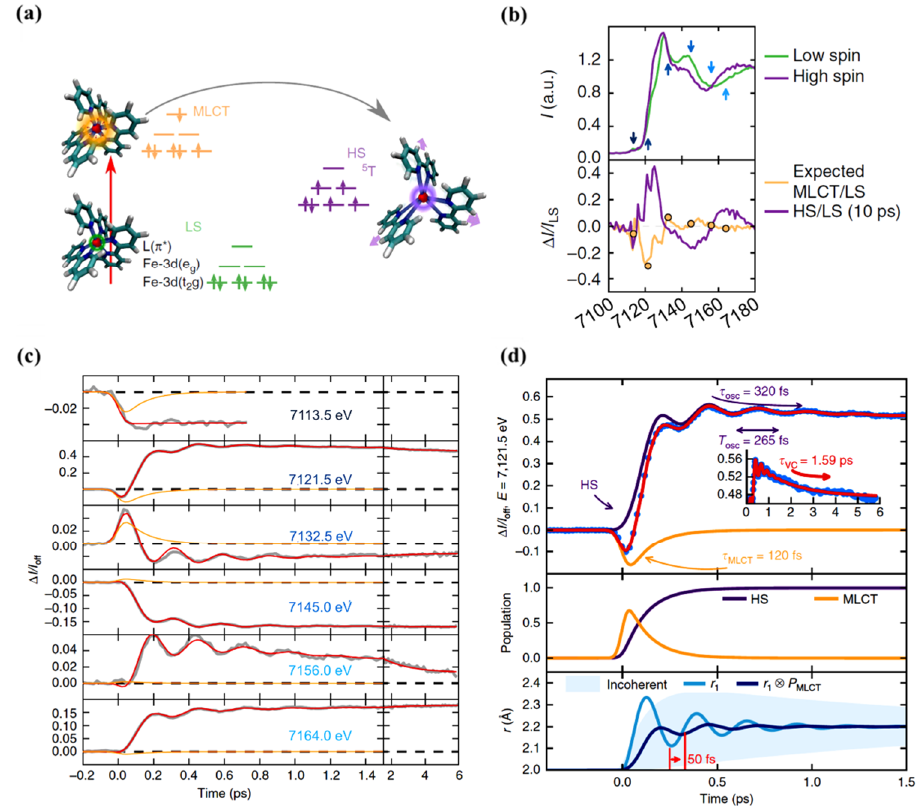
Figure 5. ( a ) A schematic representation of the spin state trapping by light for [Fe II (bpy) 3 ] 2+ . The Fe atom is represented by the small red sphere bonded to N atoms of the ligand. The low spin state initially excites to the MLCT state, and then, the system relaxes to the high spin state. ( b ) ( top ) The XANES spectra of the low spin and high spin state. The arrows indicate the photon energies for which the time resolved data was taken. ( bottom ) The high spin/low spin spectra change ratio and the expected MLCT/low spin ratio. ( c ) The femtosecond transient XANES changes ΔI(t)/I off after photo excitation for different photon energies. The red lines correspond to the global fit of the entire data set with an empirical model and the orange lines represent the MLCT contributions. The oscillating nature of the high spin and the nature of the MLCT state for 7121.5 eV photon energy (top panel). The population of the HS and MLCT states with time (middle panel). ( d ) The time evolution of the Fe-N distance r and average coherent oscillating trajectory, → r ( t ) = r 1 ( t ) × P MLCT ( t ) due to high spin population from MLCT state with respect to the time. There is a phase shift (at a delay time ~ 50 fs) due to an increase in the high spin population through a decrease in the MLCT population and also a reduction in the amplitude (bottom plane) [67].